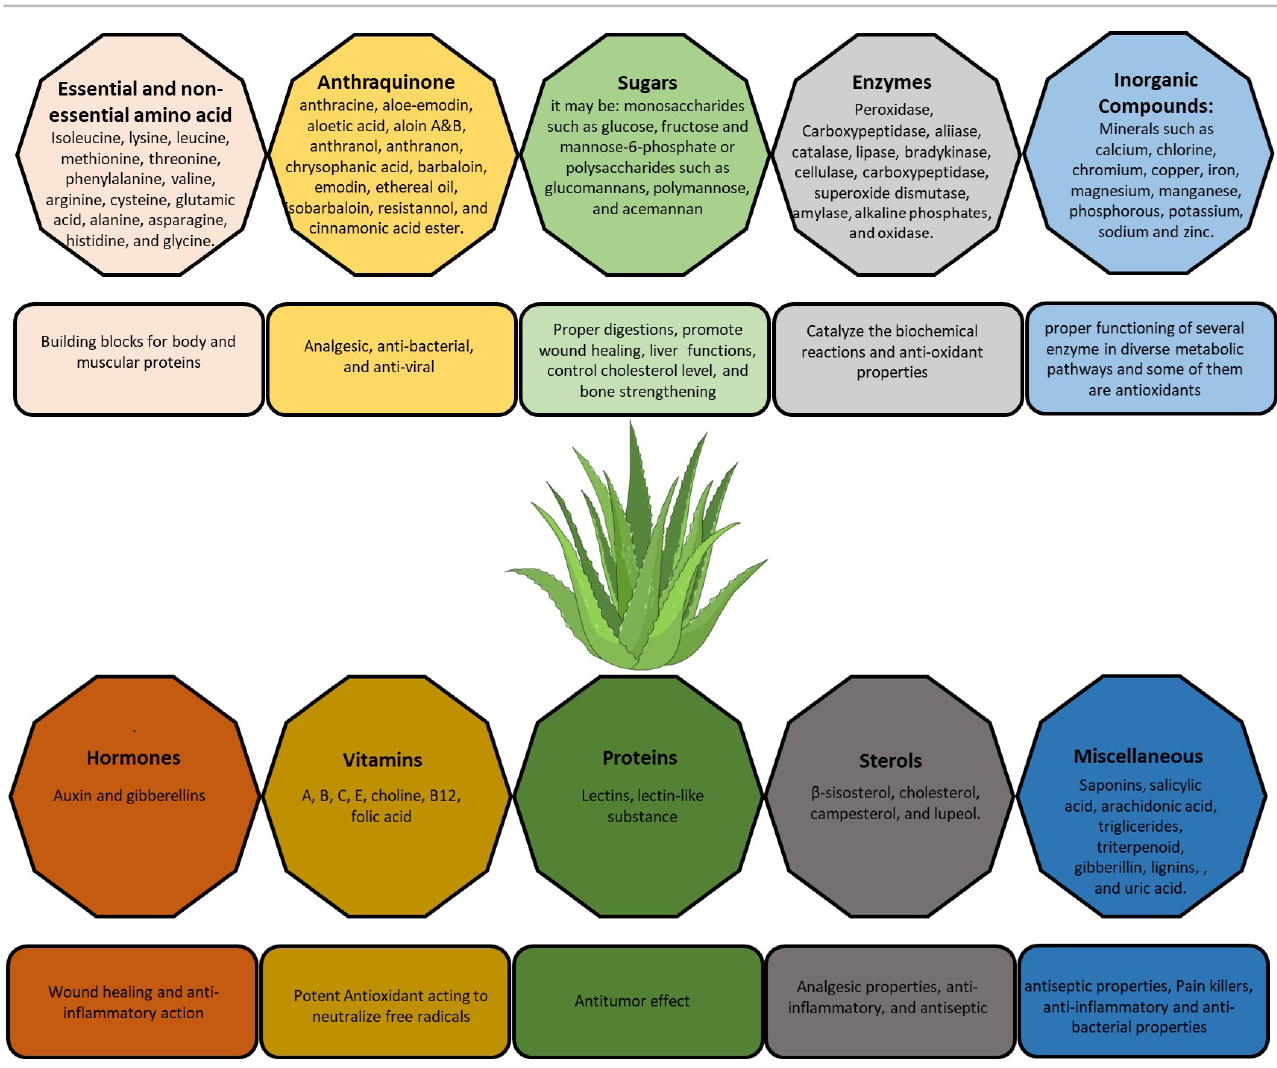
FIGURE 2 - Aloe vera bioactive ingredients and its biological